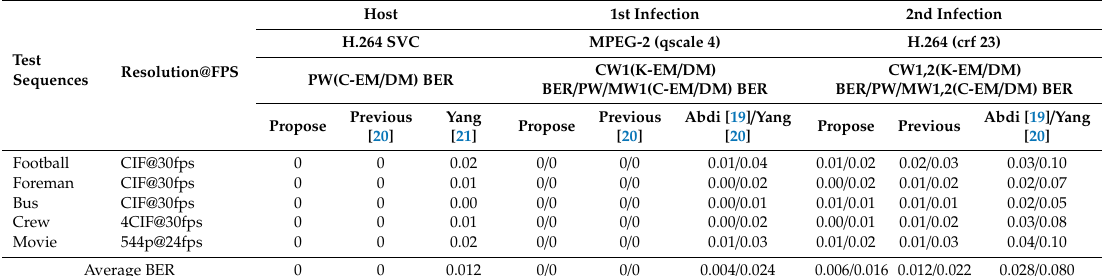
Table 3. BER results of pathogen, contagion, and mutant watermarks by MPEG2 and H.264 / MPEG4 AVC for low resolutions.